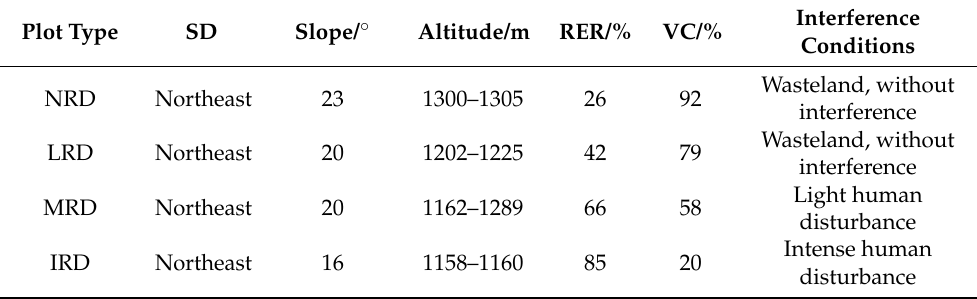
Table 2. Basic information of four rocky desertification grade samples in the study: non rocky desertification (NRD), light rocky desertification (LRD), moderate rocky desertification (MRD) and intense rocky desertification (IRD). Slope direction (SD), rocky exposure rate (RER) and vegetation coverage